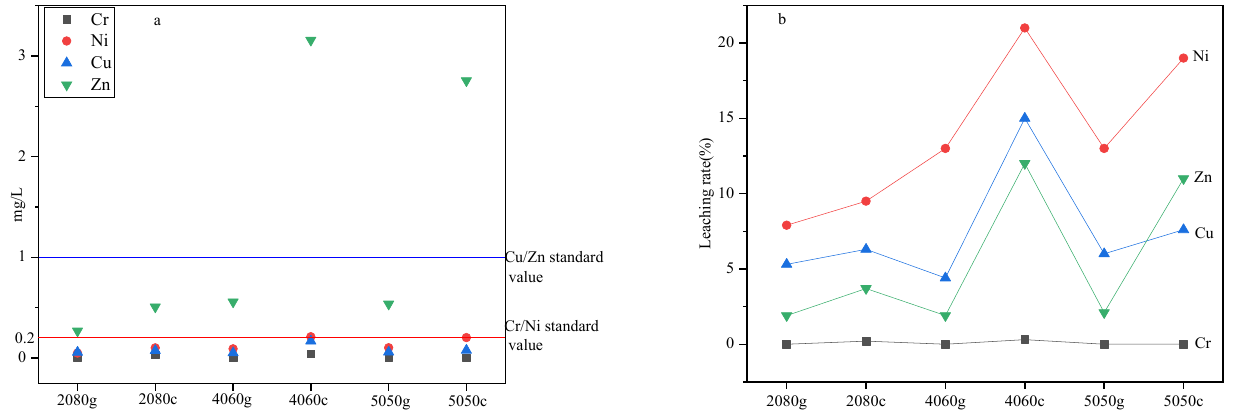
Figure 7. ( a ) Leaching toxicity and ( b ) leaching rates of HMs in glass and glass ceramic